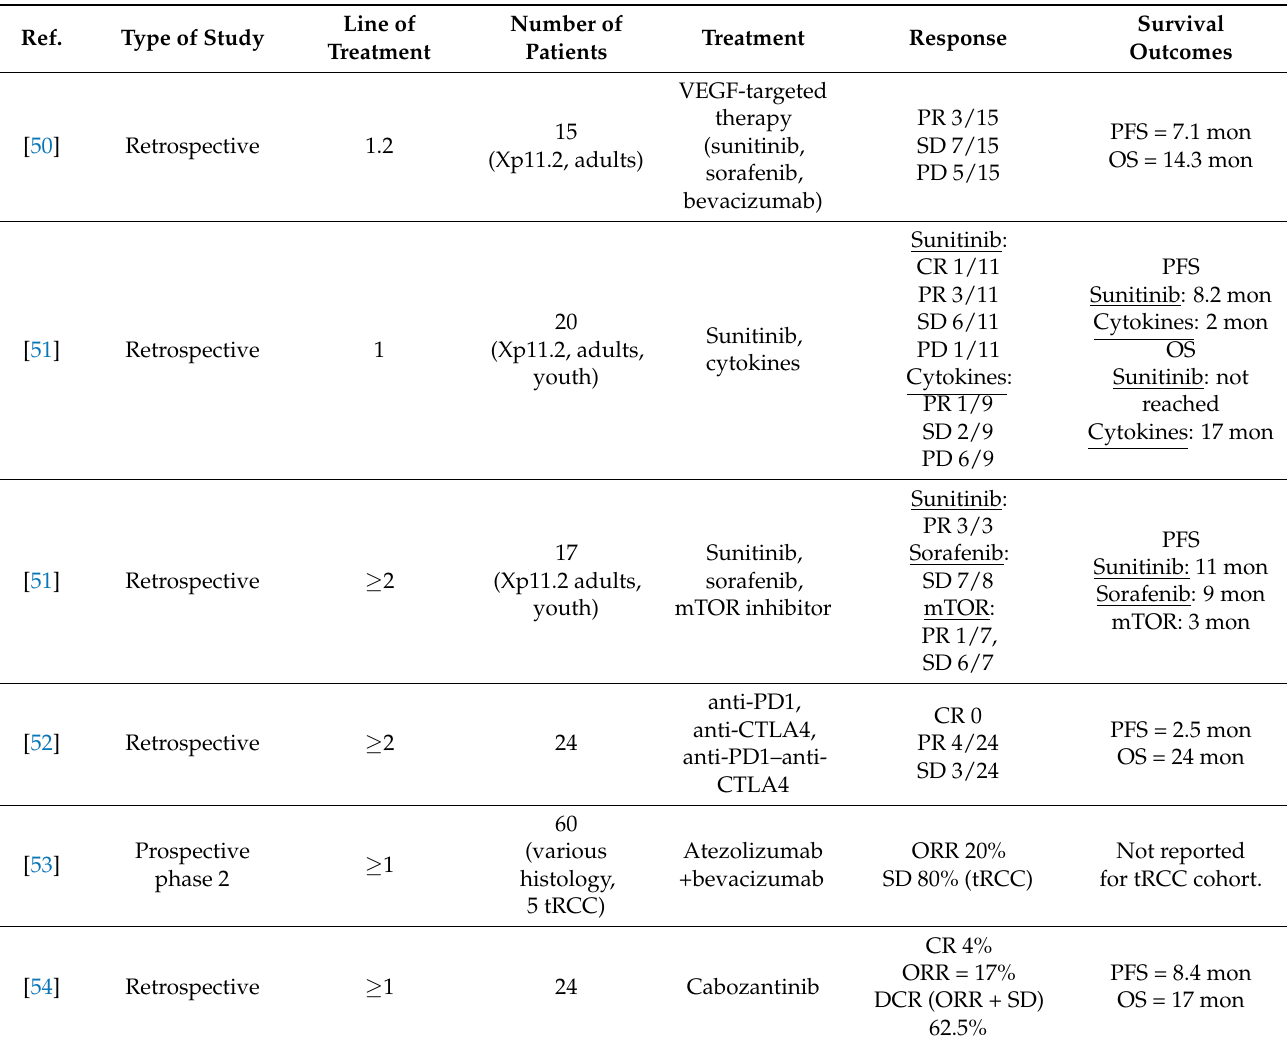
Table 4. Main available data related to tRCCs (cid:48) response to systemic therapies.